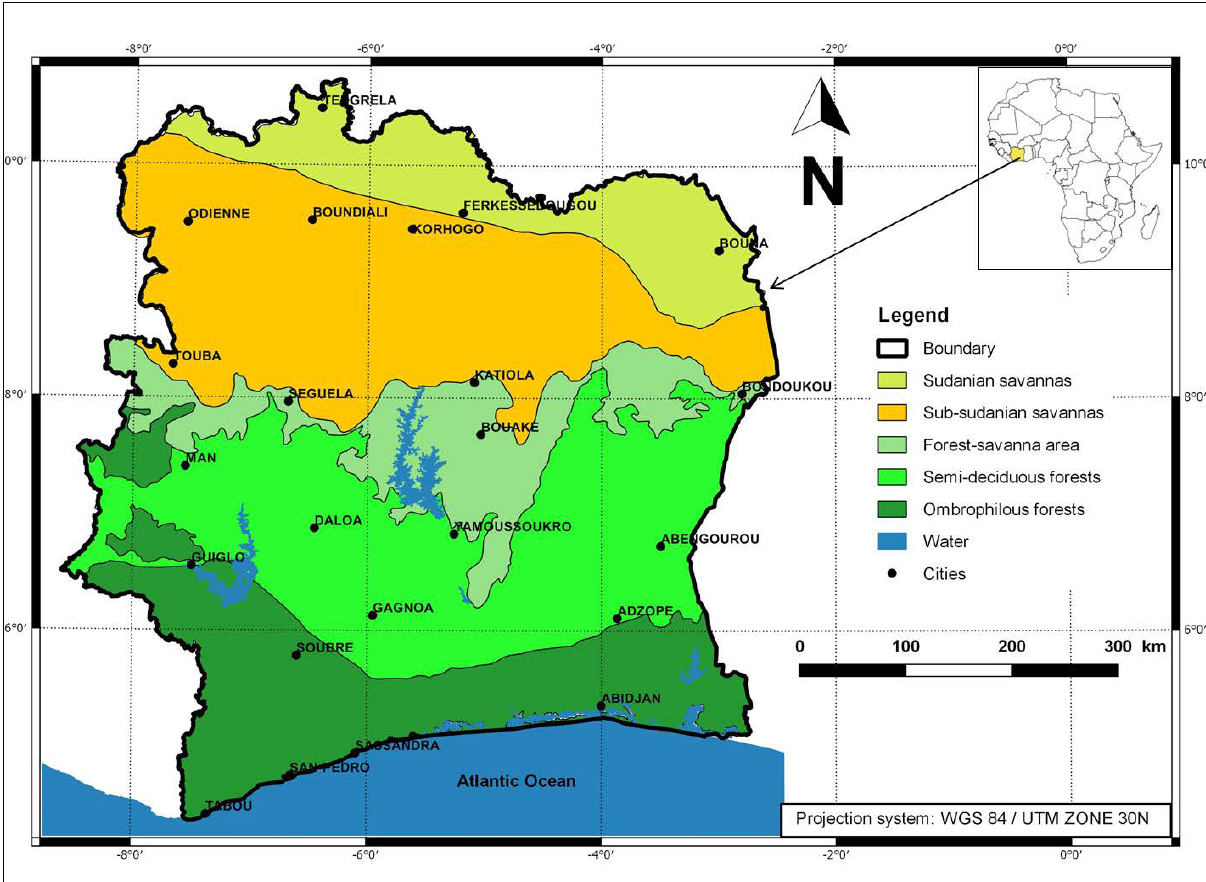
Figure 1: Study area defining the main vegetation